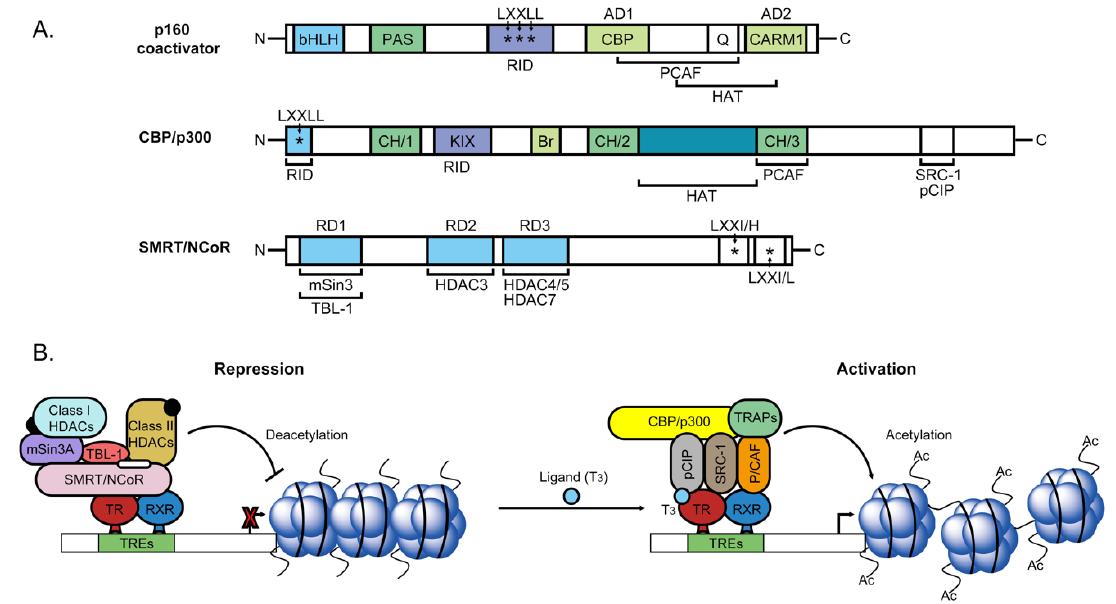
Figure 3. Schematic representation of the structure of receptor coactivators and corepressors and molecular action to regulation of genes transcription activity. ( A ) Biochemical analyses have revealed binding of a series of coactivators proteins to TRs, the most abundant of those proteins such as p160 family, and histone acetyltransferase (HAT), CREB-binding protein (CBP)/p300. Additionally, nuclear receptor corepressor (NCoR) and homolog, silencing mediator of retinoic and thyroid receptor (SMRT), are strongly associated with unliganded TR. ( B ) TRs repress gene expression in a ligand-dependent manner. TRs bind to their respective TREs with retinoid X receptors (RXR). Heterodimers of TR/RXR contain LBDs that interact with T 3 . Additionally, DBD displays high affinity for DNA sequences of TREs. TRs can directly or indirectly associate with different molecular proteins (transcription factors, coactivators, transcription intermediary factors (TIF) and corepressors) to influence downstream target gene expression.